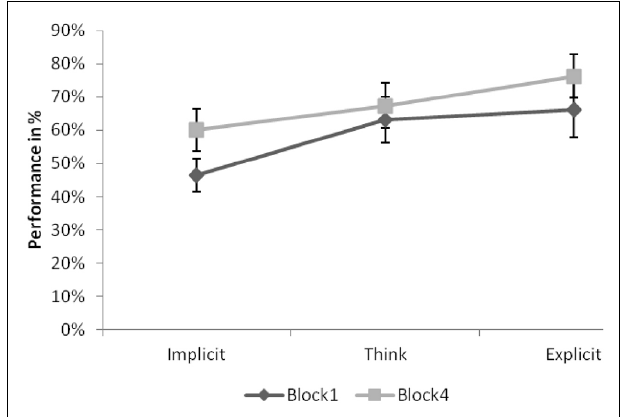
FIGURE 4 | Performance associated with implicit or explicit self-insight in Block 2 for multi-cue vs. single-cue strategists. Error bars indicate Standard